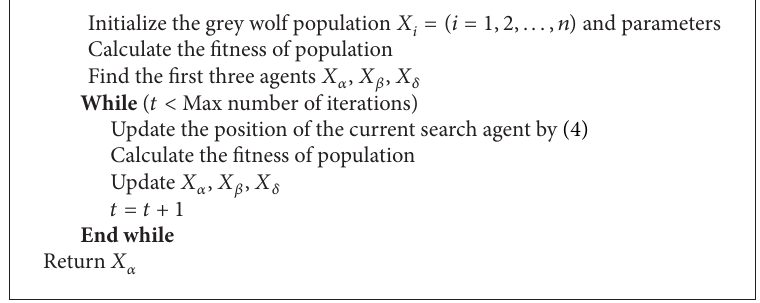
Algorithm 1: GWO algorithm.